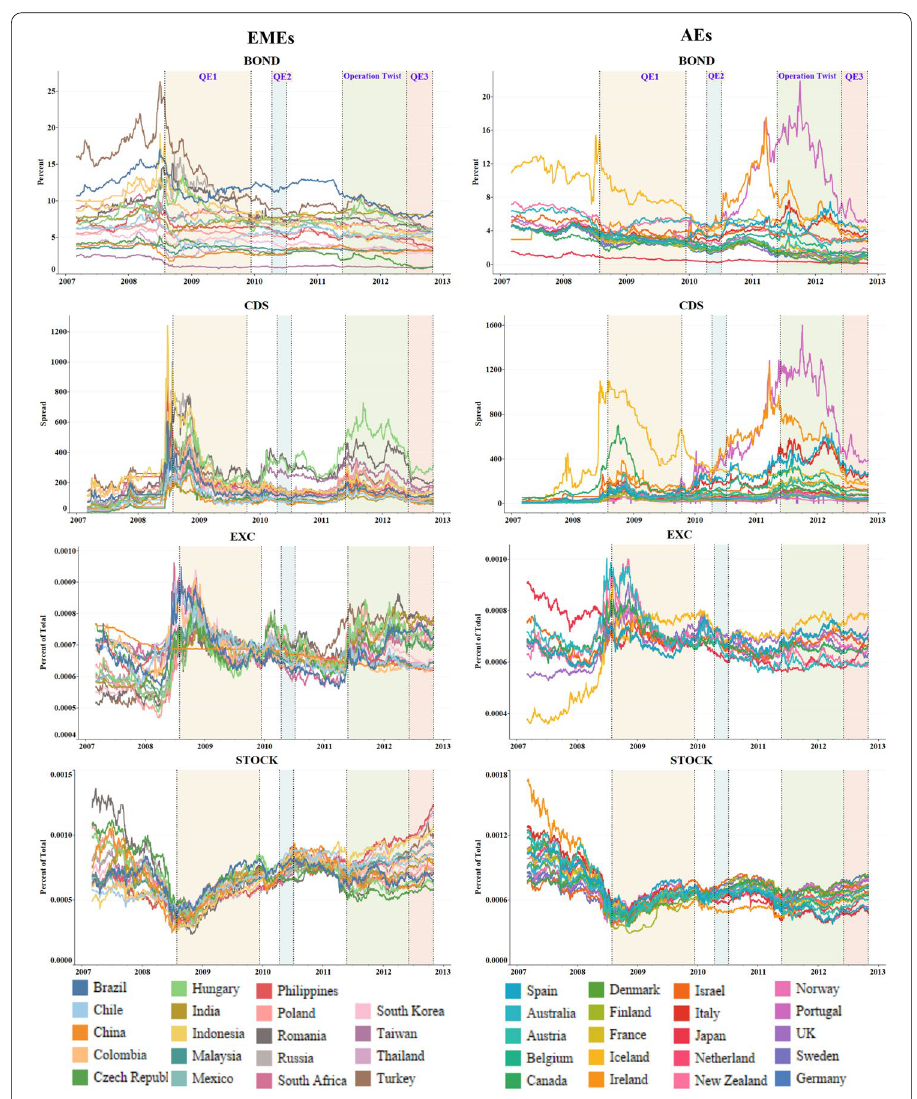
Fig. 3 Common dynamics of EME’s and AE’s financial markets during US UMP periods. BOND represents foreign long-term yields, measured by 5 year local currency government bond yields. CDS represents country risk premium, measured by 5 year sovereign CDS spreads. EXC is the exchange rate (defined as domestic currency units per unit in US dollars). A negative change in the exchange rate denotes appreciation of the domestic currency. STOCK represents equity prices. Source